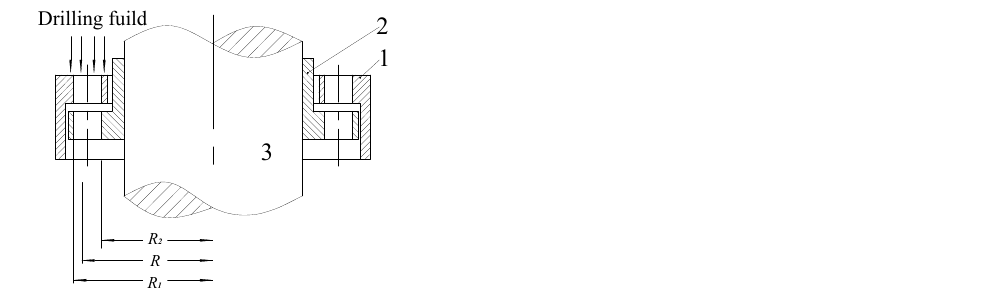
Figure 2. Sketch of the turbodrill blade assembly. 1. Stator blade 2. Rotor blade 3. Rotation shaft.